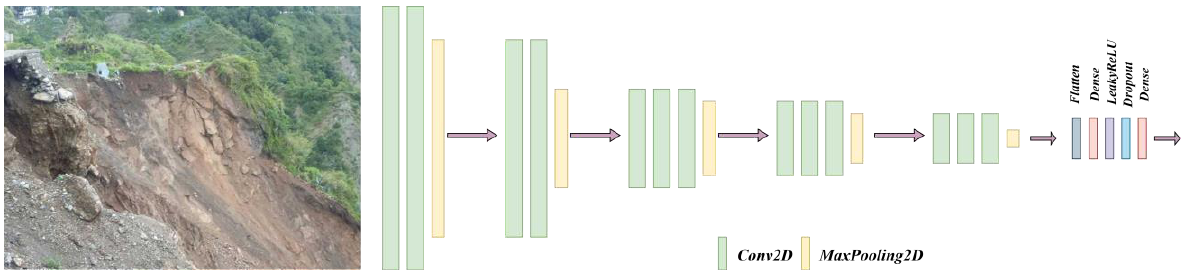
Figure 6. CNN architecture used for quality assessment (modified after Can et al., 2019).